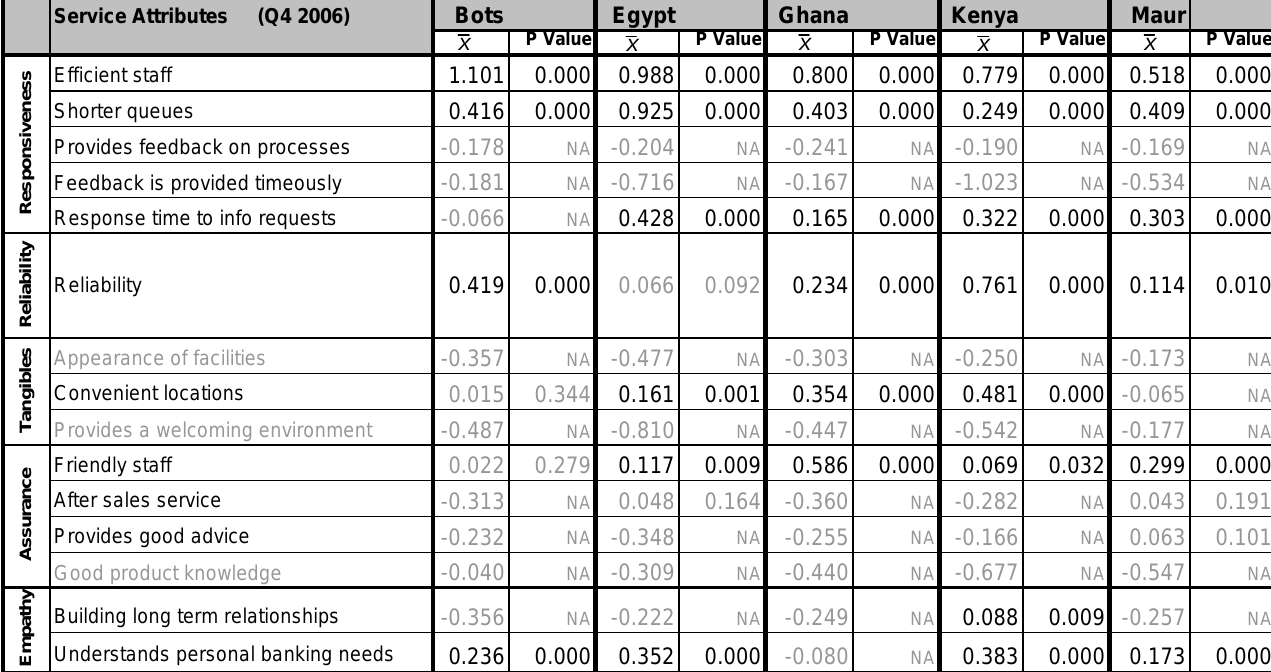
Table 8: Significance of attribute means by